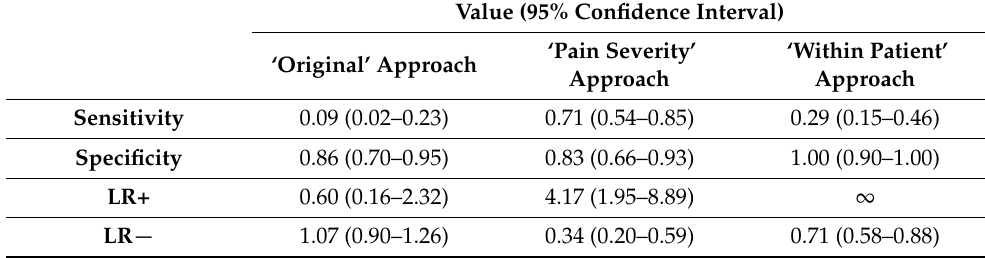
Table 4. Diagnostic values for the original coracoid pain test. Value (95% Confidence